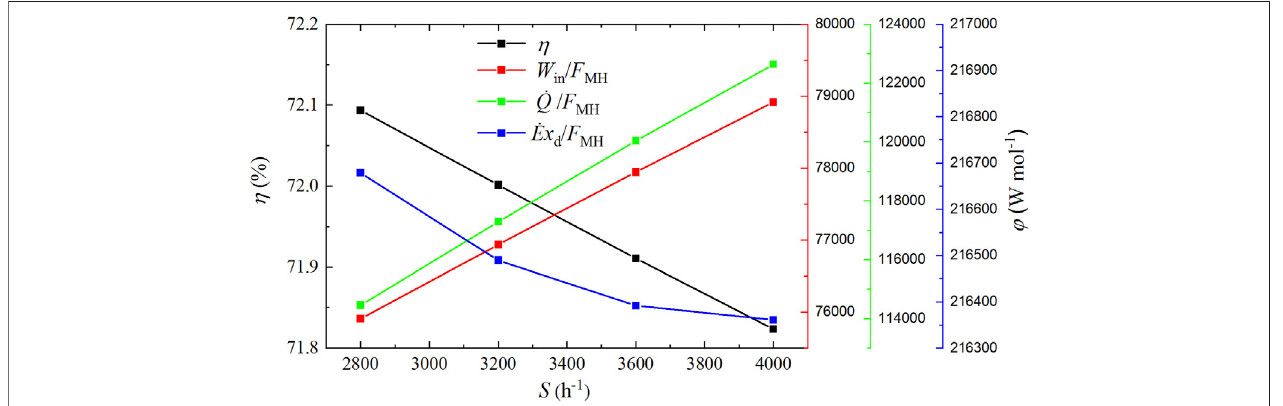
FIGURE 10 | Input power, cold energy, and exergy destruction per molar synthetic methanol and exergy ef fi ciency under different space velocities.